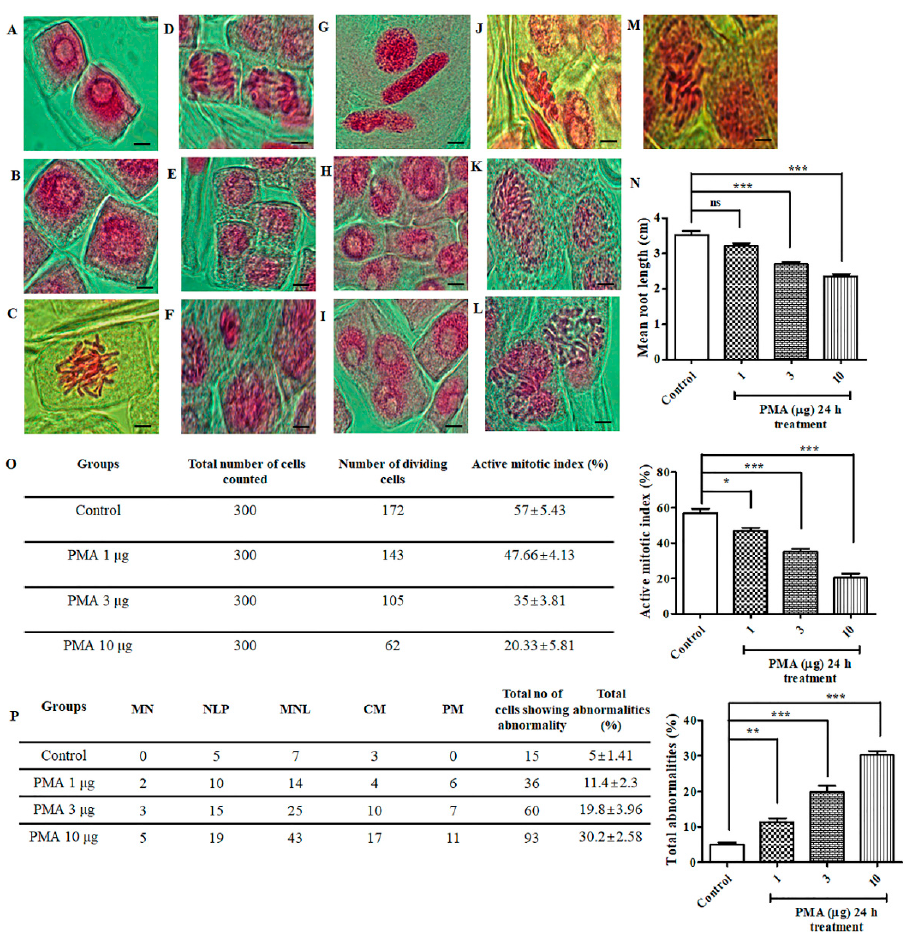
Figure 1. Chromosomal aberrations induced by phorbol 12-myristate 13-acetate (PMA) in the root